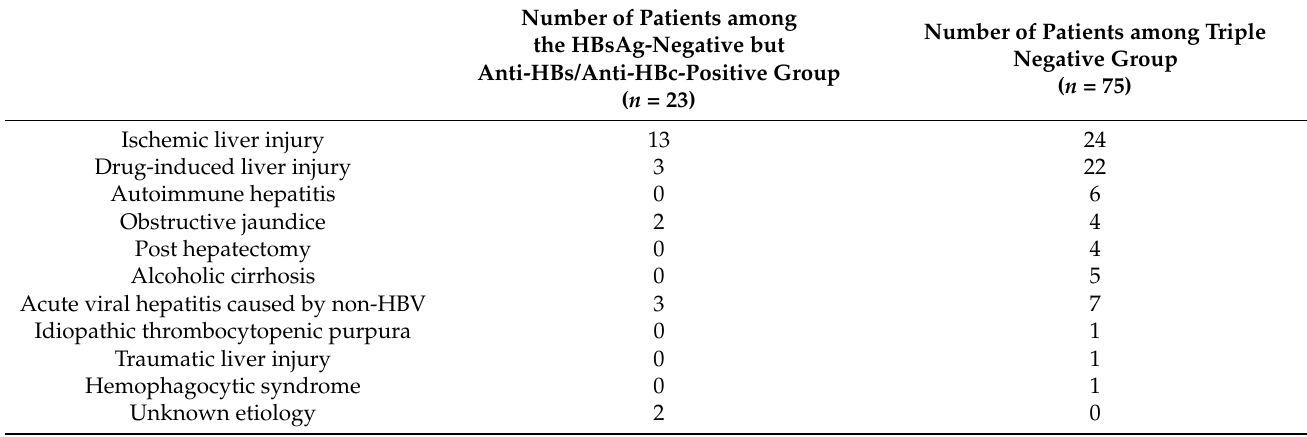
Table 5. Various types of liver diseases causing non-hepatitis B virus (HBV) related higher alanine transaminase (ALT) elevations than 1000 IU/L among the HBV surface antigen (HBsAg)-negative but anti-HBV surface antibody (anti-HBs)/anti- HBV core antibody (anti-HBc)-positive group and triple negative